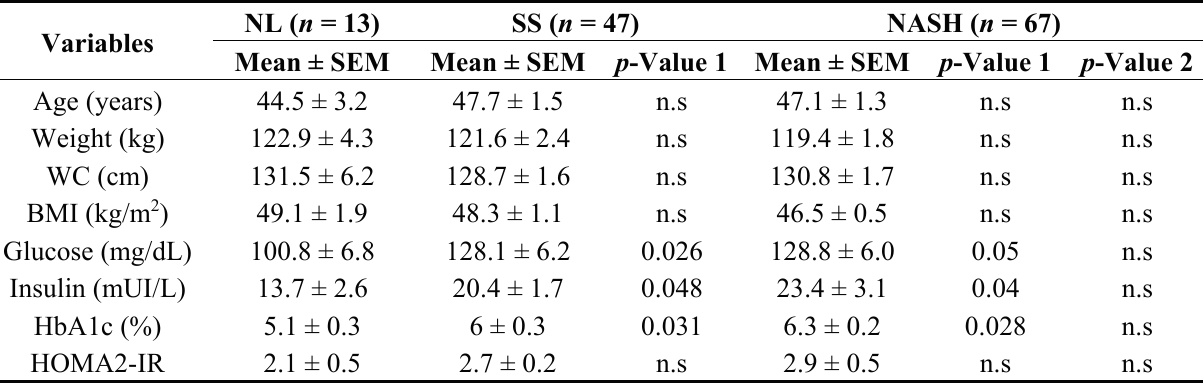
Table 1. Anthropometric and metabolic variables of the study cohort classified according to the liver